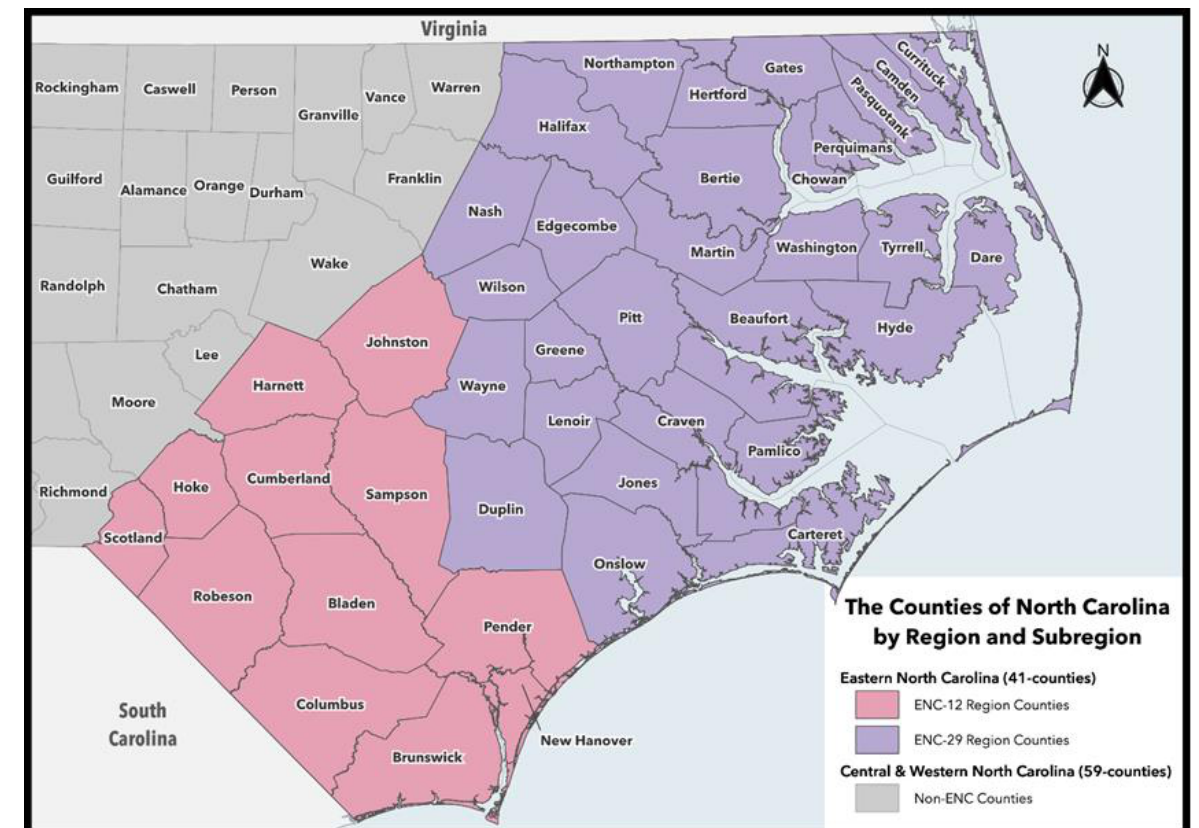
Figure 1. Eastern NC eNC-29 region counties. Map provided by the ECU Center for Geographic Information Science (https://gis.ecu.edu).